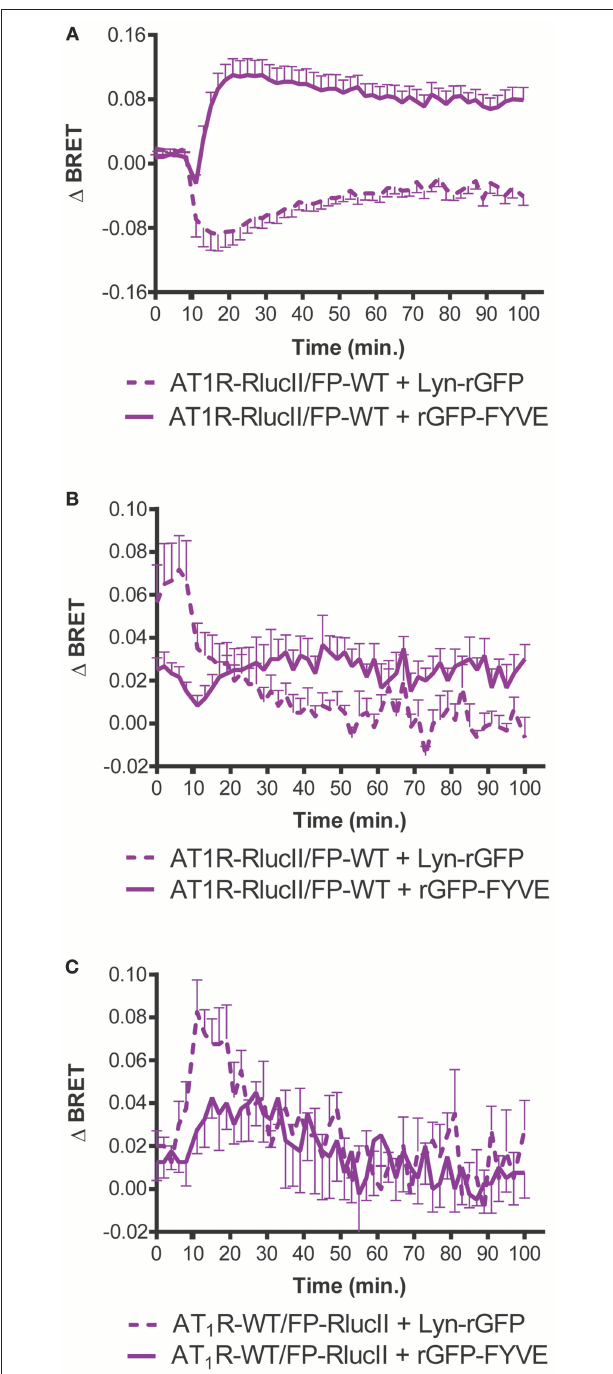
FIGURE 3 | Enhanced bystander BRET shows FP can stimulate AT1R internalization. HEK293 cells were transfected with the indicated enhanced BRET pairs. To monitor AT1R- or FP-mediated trafficking of AT1R-RlucII from the membrane (loss of Lyn-rGFP bystander BRET) or endosomal trafficking (as measured by increase in rGFP-FYVE bystander BRET), AT1R-RlucII were co-transfected with wildtype FP and the indicated bystander BRET partner. Cells were stimulated with (A) 1 µ M Ang II or (B) 1 µ M PGF2 α and monitored over time. (C) FP-RlucII were co-transfected with wildtype AT1R and the